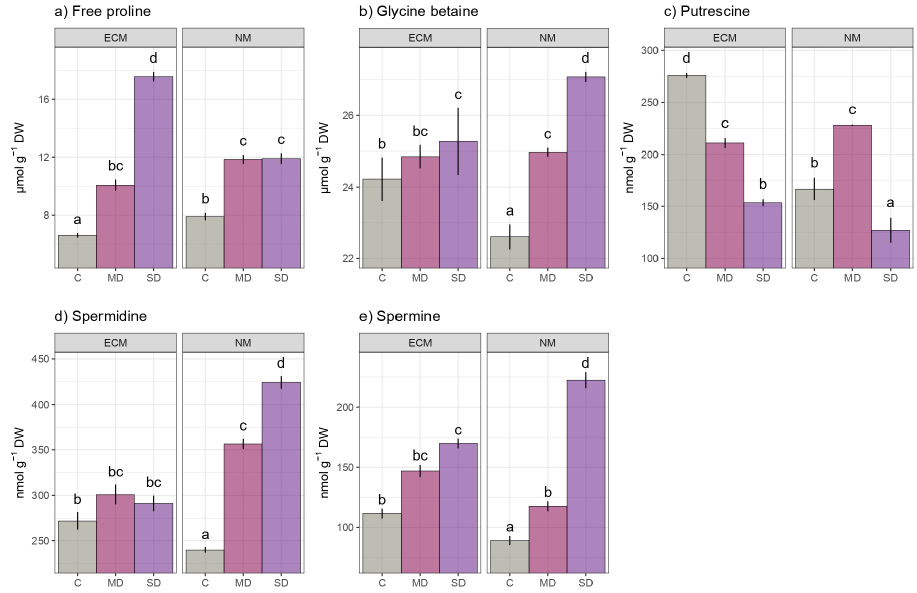
Figure 3. The effects of mycorrhization and/or drought on osmolyte levels: ( a ) Proline (PRO; mmol g − 1 DW), ( b ) Glycine betaine (GB; mmol g − 1 DW), ( c ) Putrescine (PUT; nmol g − 1 DW), ( d ) Spermidine (SPD; nmol g − 1 DW), ( e ) Spermine (SPM; nmol g − 1 DW) in leaves of Q. robur . Treatments: C-control regularly watered oak seedlings, MD-oak seedlings exposed to the mild drought that corresponds with 60% of soil water field capacity, SD- oak seedlings exposed to the severe drought that corresponds with 30% of soil water field capacity ECM-oak seedlings inoculated with ectomycorrhizal inoculum, and NM-oak seedlings not inoculated with ectomycorrhizal inoculum. Different small letters indicate significant differences across the different treatments; Tukey’s honestly significant difference (HSD) post hoc test ( p ≤ 0.05). Data represent the mean ± standard deviation (SD).